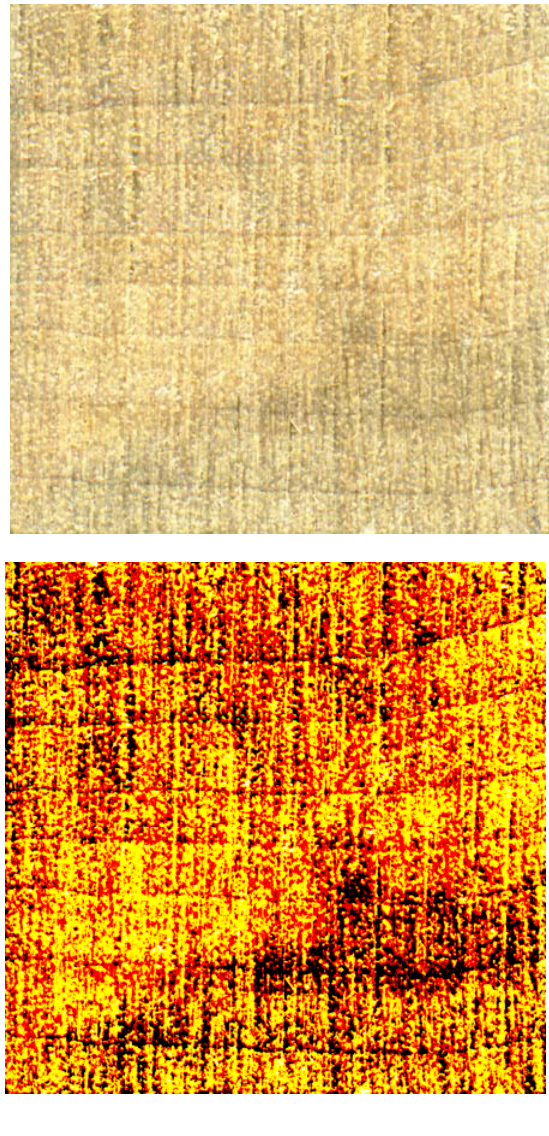
Figure 4 . Original scan (A) and increased saturation scan (B) of an Arthrographis cuboidea inoculated block. Blue pigments have been saturated to true black and dark